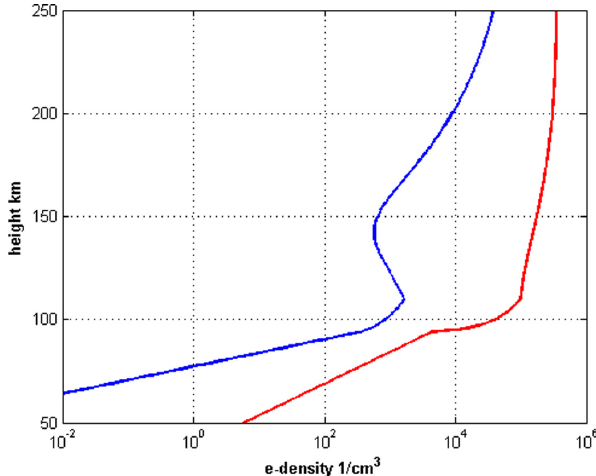
Fig. 6. Undisturbed electron-density profiles for midnight (blue; D-layer parameters: h 0 = 87km, β = 0 . 5) and noon (red; D-layer parameters: h 0 = 74km, β = 0 .